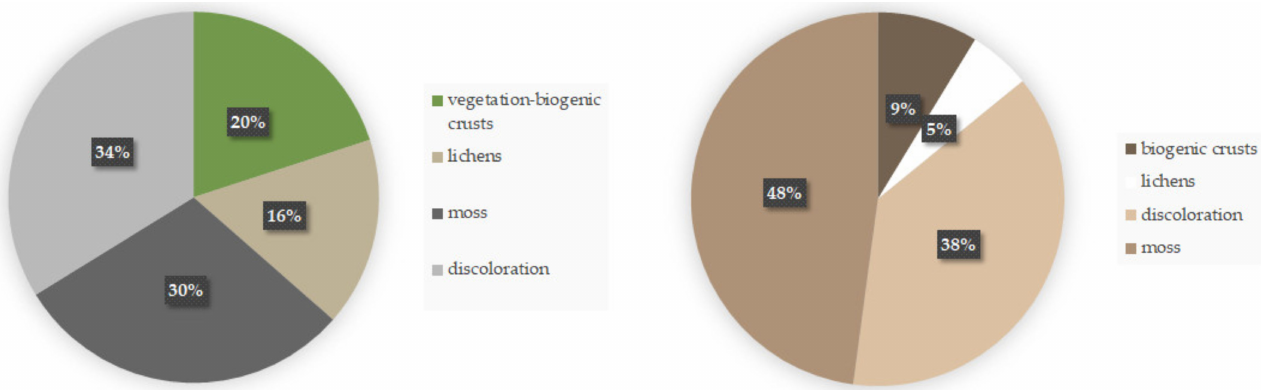
Figure 15. Degradation pattern statistics for the investigated surfaces at the remains of the Temple of Athena and Zeus Sotiros; cella wall ( left ) and cubic stone pedestal ( right